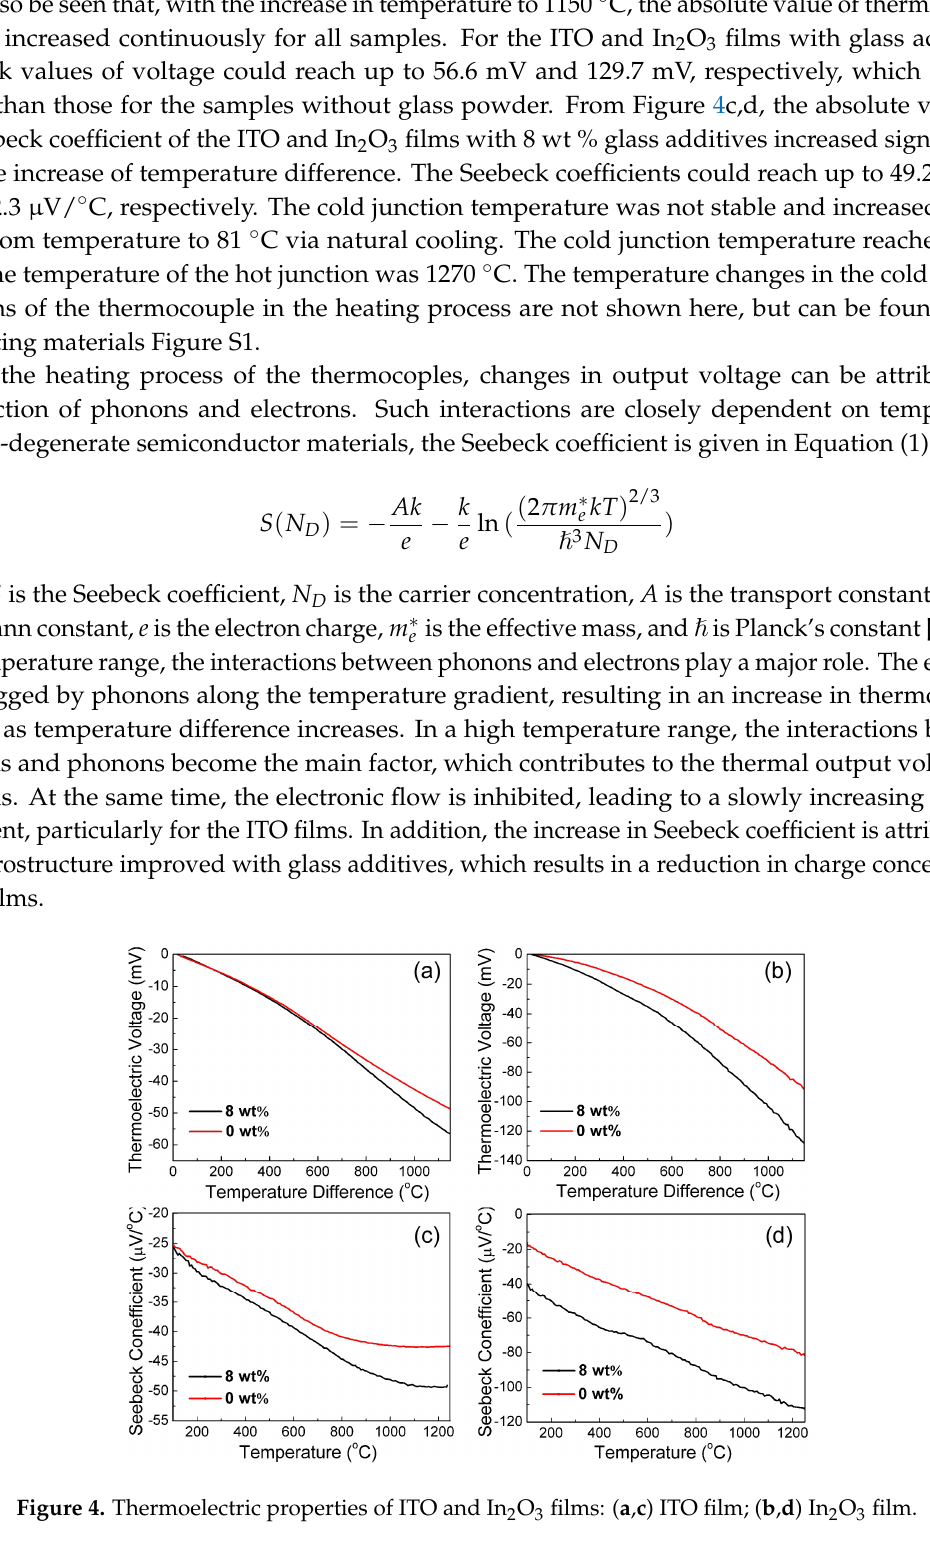
2 O 3 films: ( a , c ) ITO film; ( b , d ) In 2 O 3